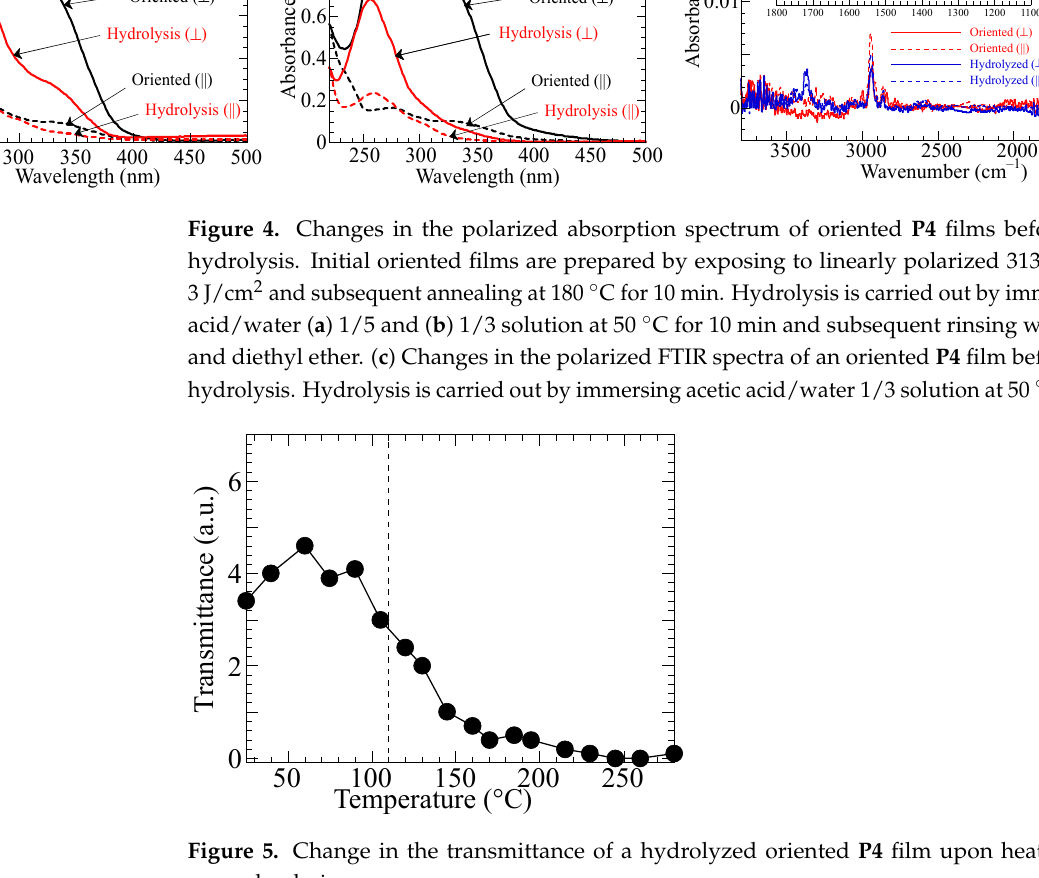
crossed polarizers.